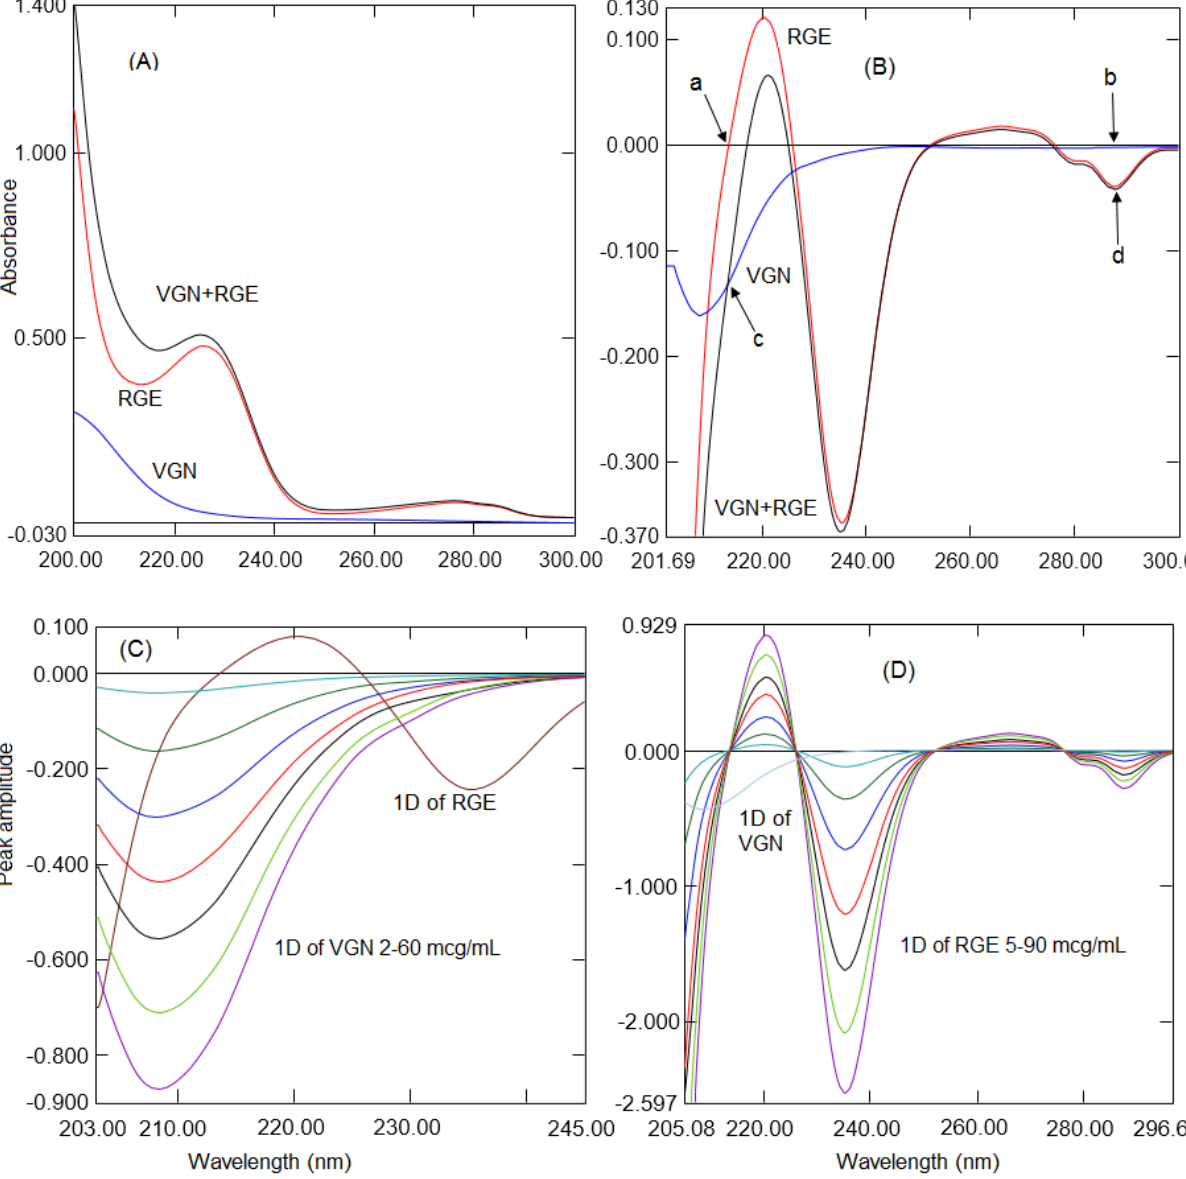
Figure 2. ( A ) Normal spectra of RGE, VGN, and a mixture. ( B ) First derivative spectra of RGE, VGN, and the mixture. Zero-crossings of RGE (a), zero-crossings of VGN (c), and the same amplitude points (b and d). ( C ) First derivative spectra of VGN 2 to 60 µg/mL with the RGE spectrum. ( D ) First derivative spectra of RGE 5 to 90 µg/mL with the VGN spectrum.